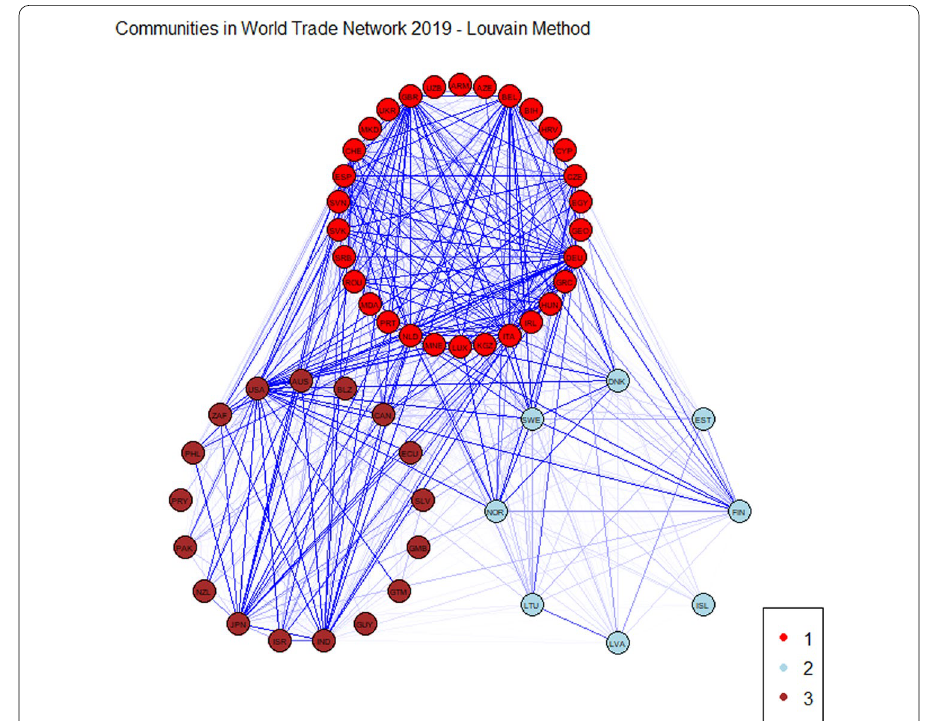
Fig. 5 Communities obtained with the Louvain method referred to